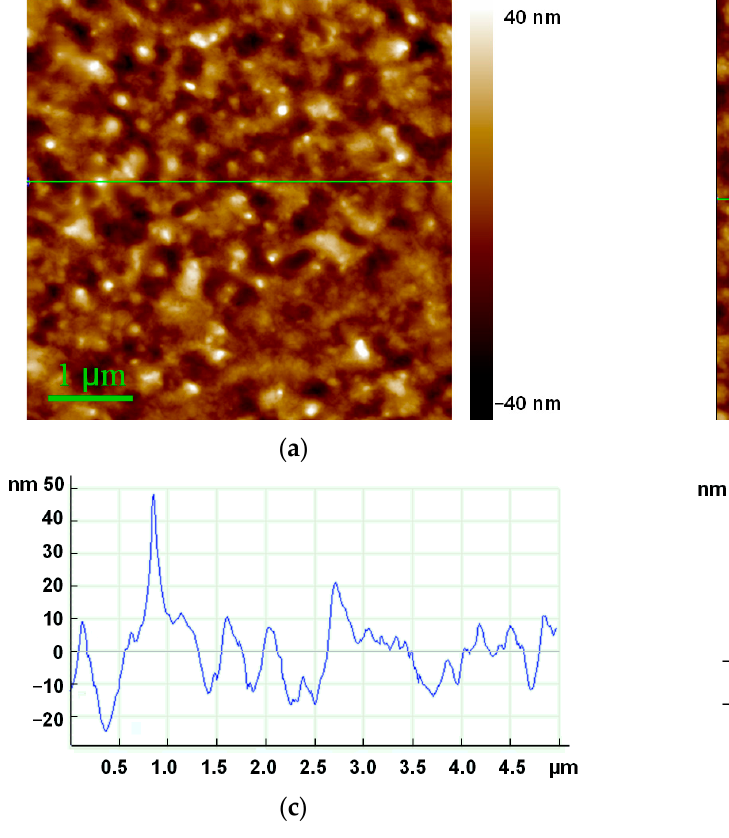
Figure 4. Atomic force microscopy (AFM) images of 65 nm thick films of ( a ) Cu ‐ PP ‐ IX and ( b ) Cu ‐ C ‐ e6; ( c , d ) height profiles along the indicated green lines shown in panel ( a , b ), correspondingly.